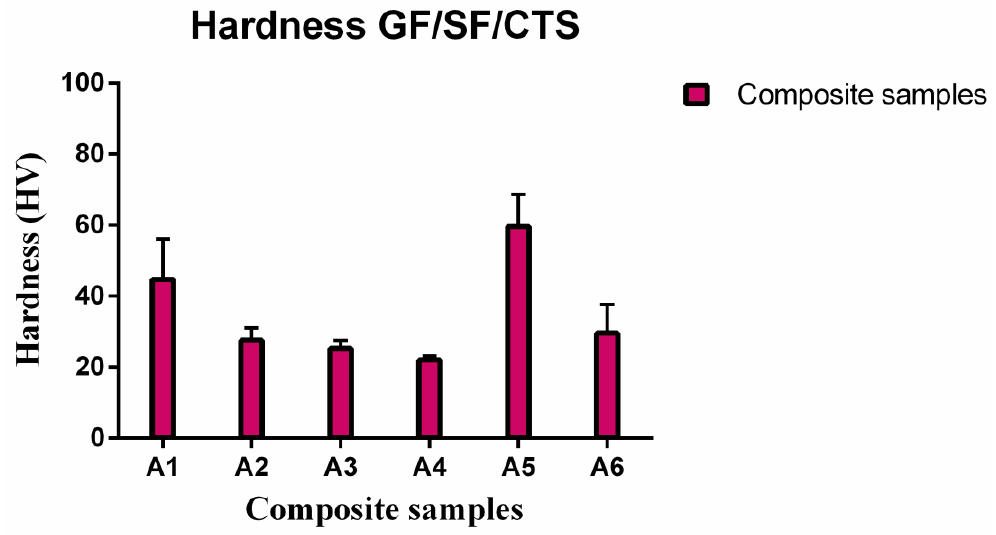
Figure 9. Micro hardness of GF / SF / CTS composite sca ff olds.